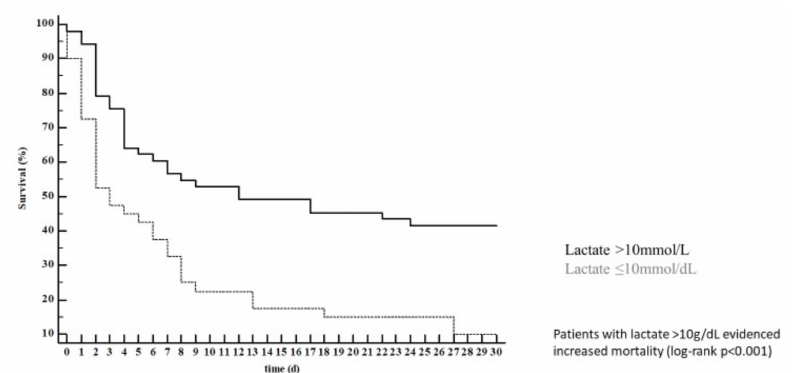
Figure 1. Patients with lactate >10 g/dL showed increased mortality (log-rank p < 0.001).